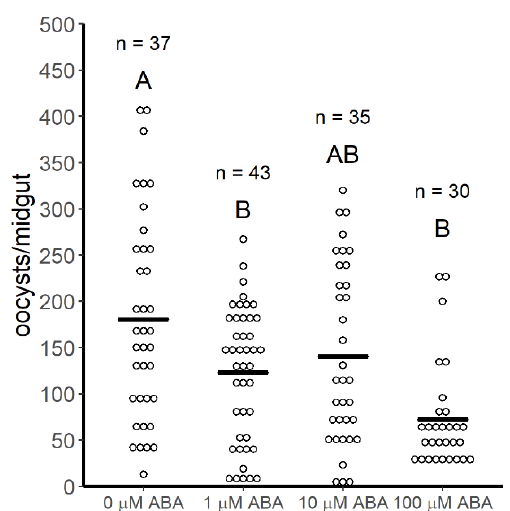
Figure 2. Infection intensity (mean P. y. yoelii 17XNL oocysts per infected midgut from mosquitoes in